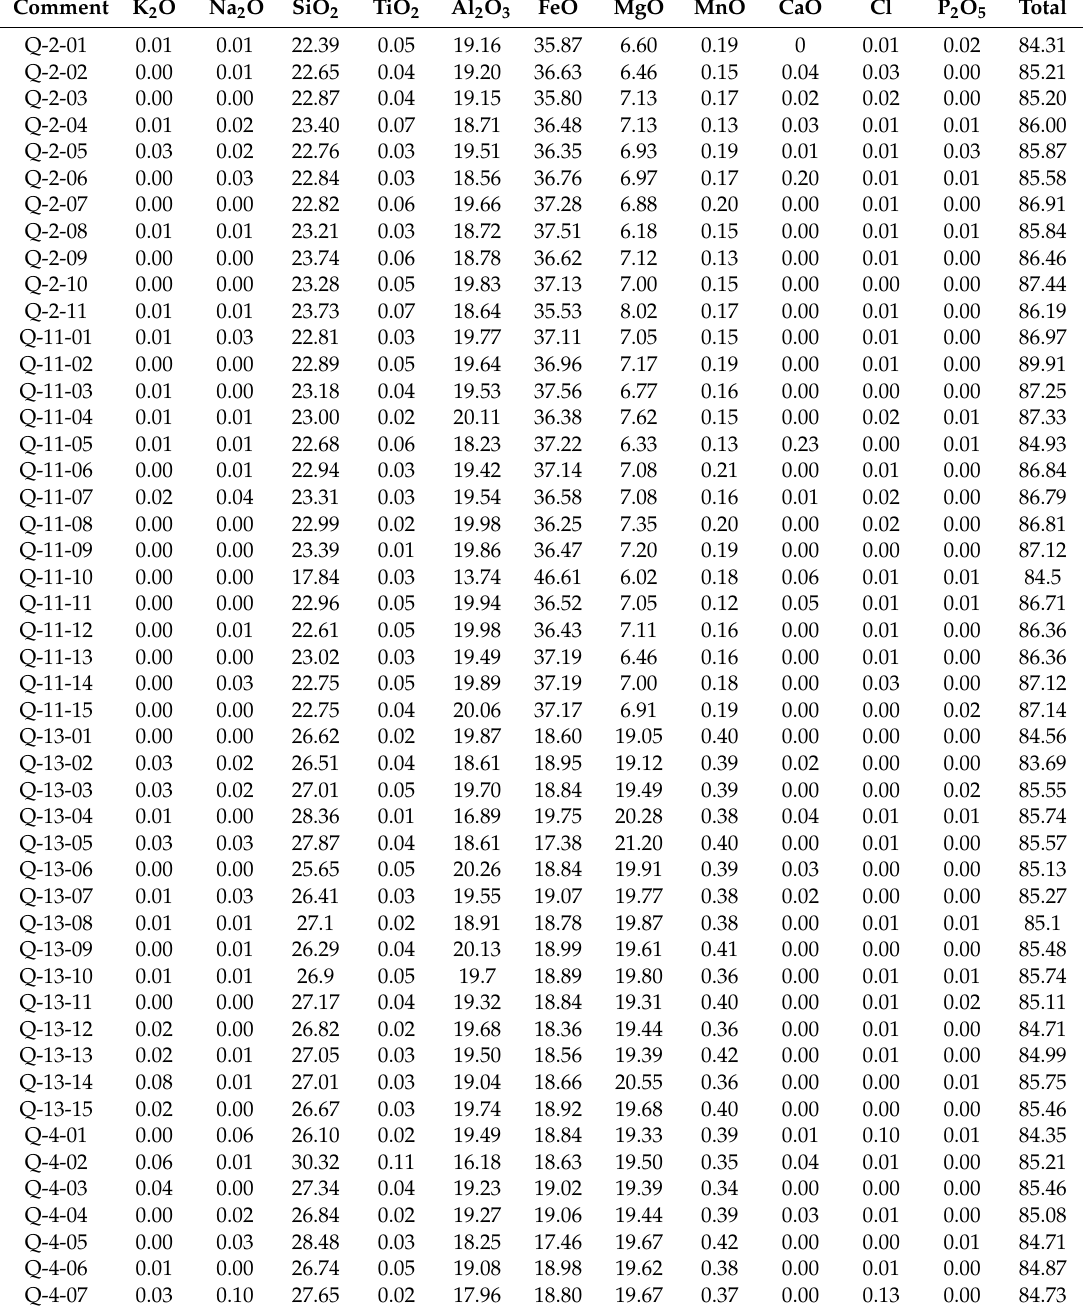
Table 1. The electron probe microanalyzer (EPMA) analysis result of the chlorite chemical